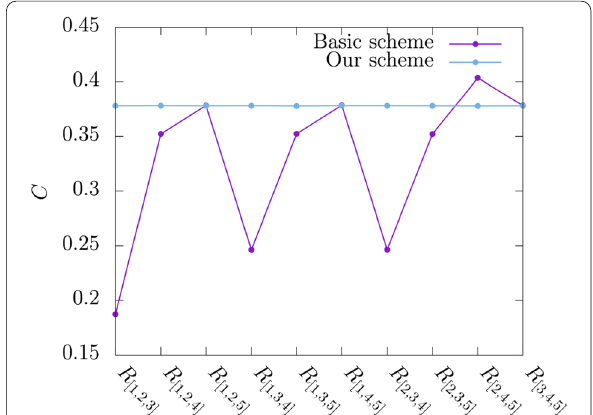
Fig. 8 Amount of information C in R 3 of two schemes